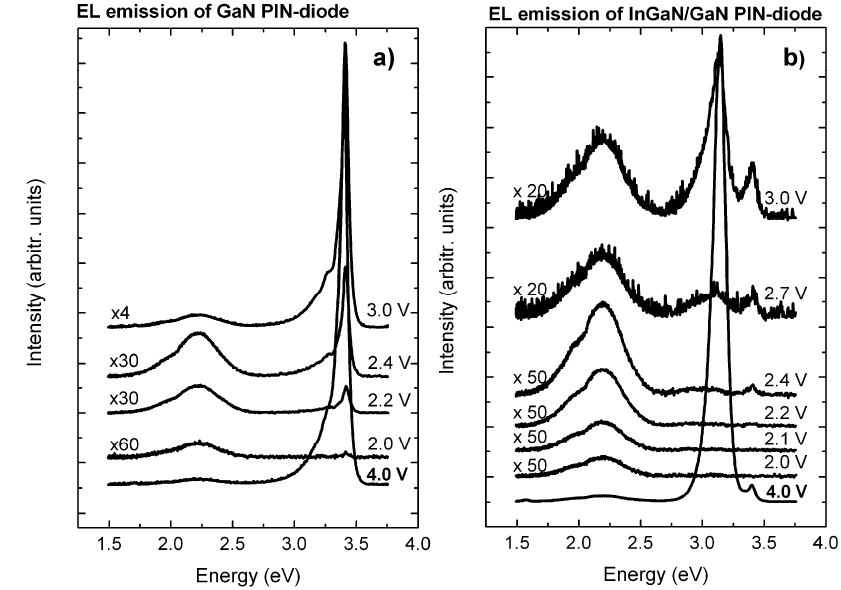
Figure 10. EL emission spectra of PIN-diodes based on ( a ) GaN reference structure and ( b ) In 0.055 Ga 0.945 N / GaN DHS in dependence of DC bias-voltage.